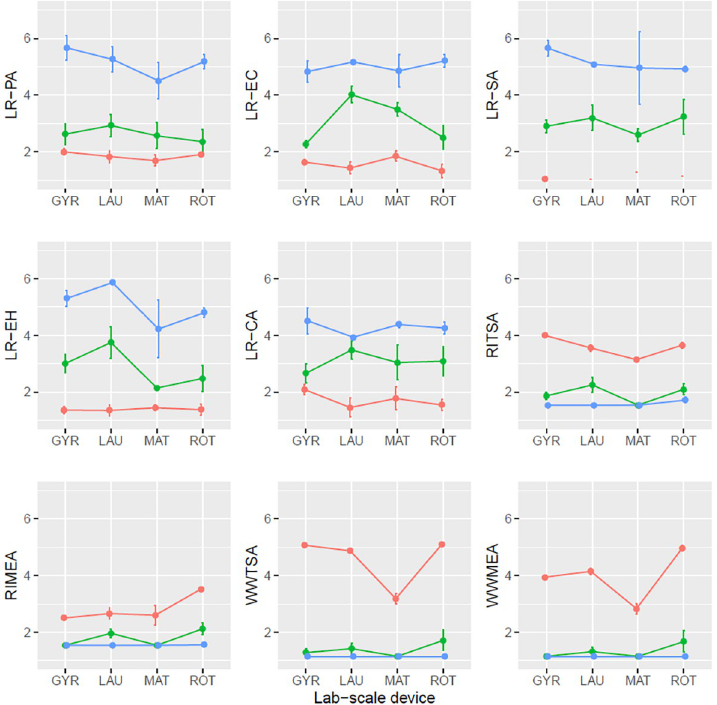
Fig 3. Mean plot with standard error bars of the different variables for the rinse cycle. LR : Logarithmic reduction, PA : P . aeruginosa , EC : E . coli , SA : S . aureus , EH : E . hirae , CA : C . albicans , R I : Cross- contamination carrier, W W : Wash water, TSA : Trypticase soy agar, MEA : Malt extract agar, GYR : Gyrowash (James heal), LAU : Launderometer (SDL Atlas), LIN : Linitest (SDL Atlas), MAT : Labomat BFA-24 (Mathis AG). Lines in blue: Concentration D; lines in green: Concentration E; lines in red: Concentration